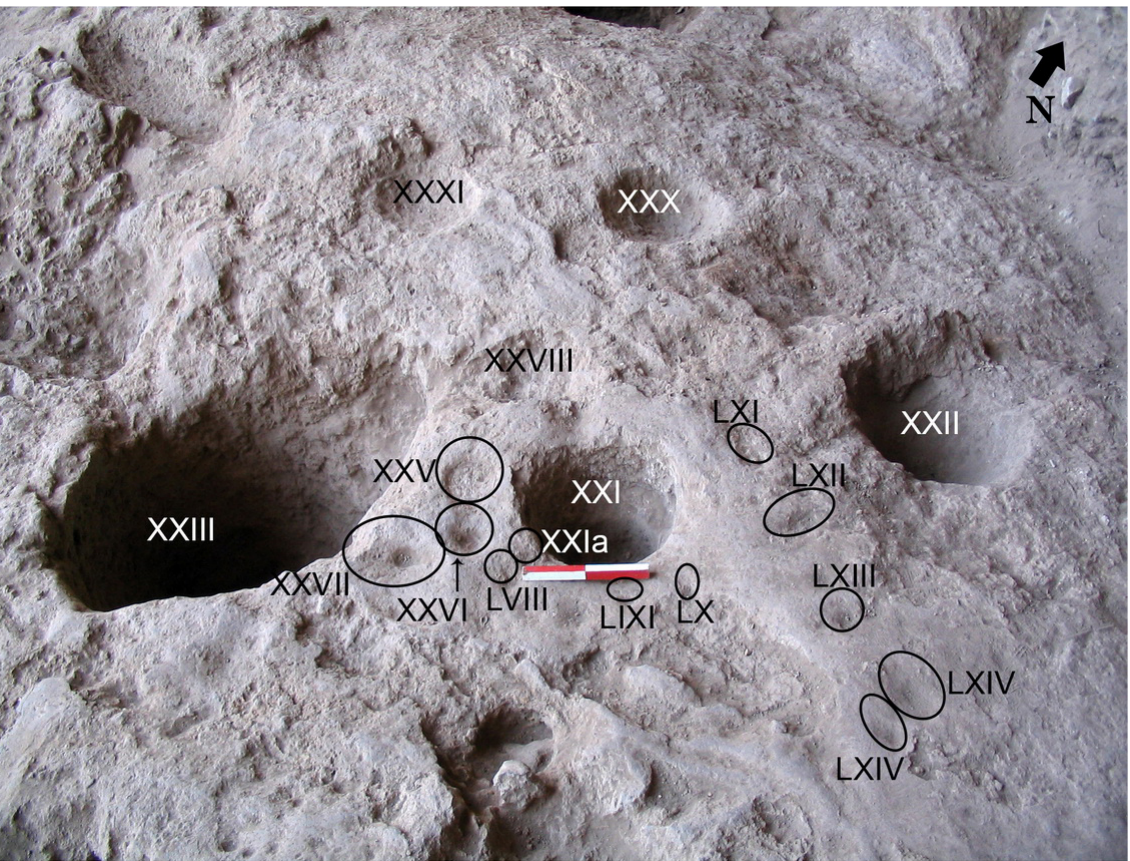
Figure 3. The highest concentration of bedrock features on the floor of chamber 1, Raqefet Cave. The largest Natufian bedrock basin (C-XXIII) is located here; the deep narrow mortar C-XXI is in the center, with a variety of features around it. Mortar C-XVIII is to the left, beyond the photo. Scale 20